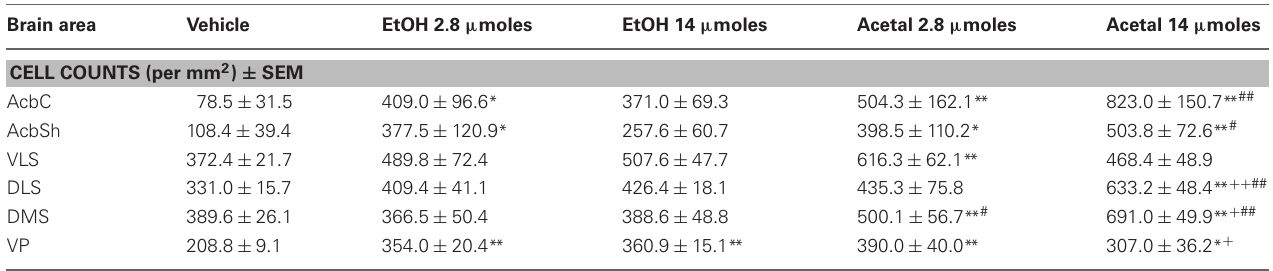
Table 5 | Effect of acute ICV administration of EtOH or acetaldehyde on c-Fos expression in basal ganglia areas of rat brain. Brain